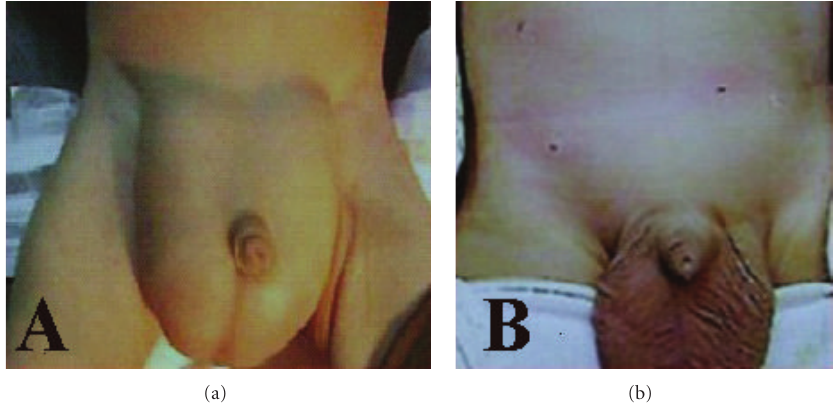
Figure 3: (a) Bilateral huge inguinal hernia. (b) Postoperative view.